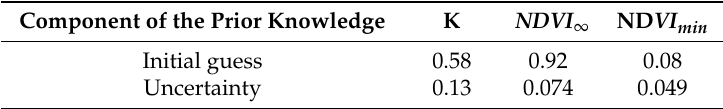
Table 3. A priori knowledge of model parameters for crops.